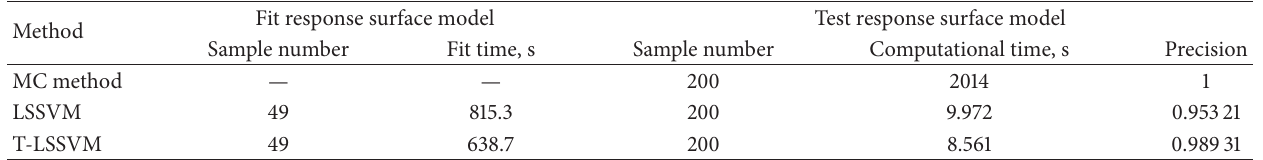
Table 4: Optimization results of three methods (RSM, ERSM, and MC